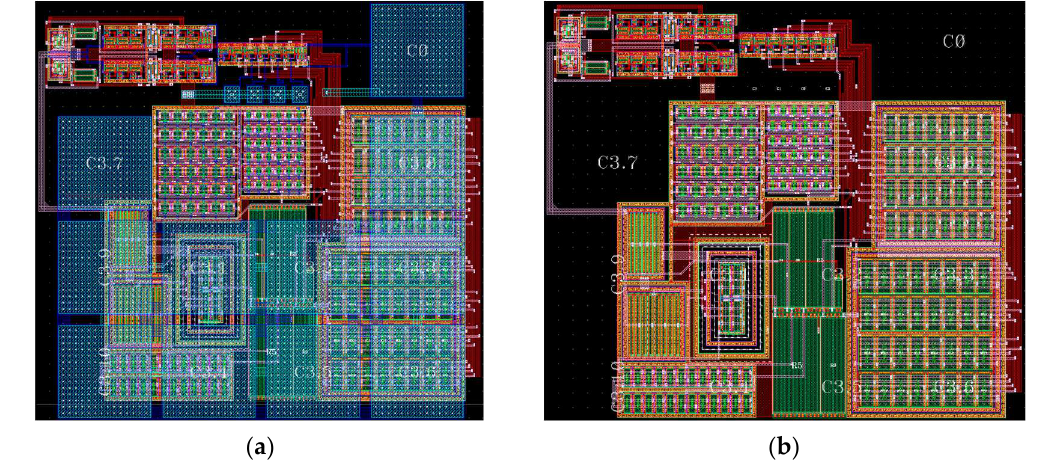
Figure 12. Circuit layout. ( a ) including M3 and M4 masks; ( b ) without MIM capacitors. The capacitors were placed over the circuit analogic part to improve the die